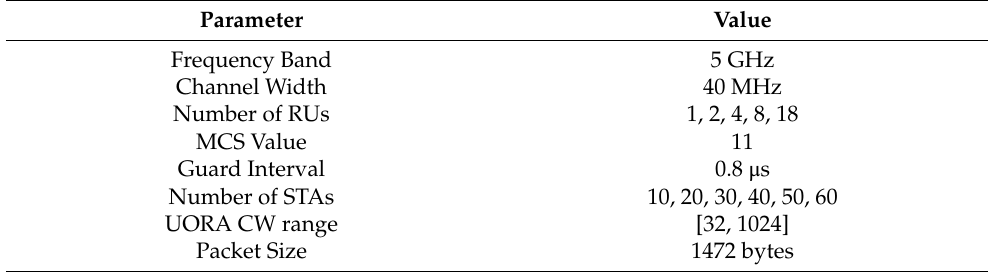
Table 3. Parameters used in the simulation.